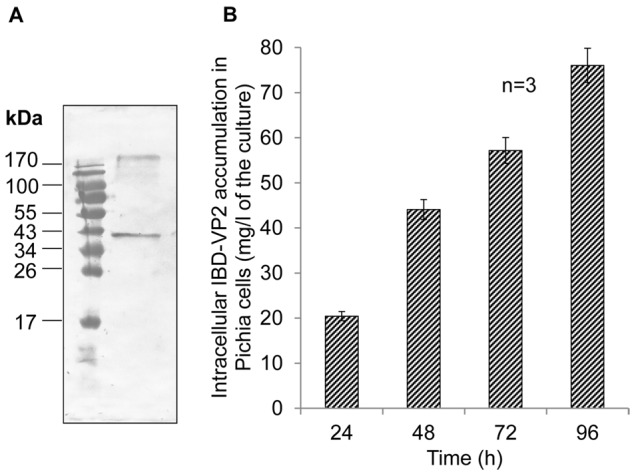
Characterization of recombinant IBD-VP2 produced in Pichia pastoris.(A) A 12-µl aliquot of the P. pastoris cell lysate was separated by SDS-PAGE (12% (w/v) polyacrylamide) and blotted onto a nitrocellulose membrane. The antigen was detected using a rabbit anti-IBD-VP2 (1∶10,000) primary antibody and an alkaline phosphatase-conjugated goat anti-rabbit secondary antibody (0.12 µg/ml). The signal was detected with NBT/BCIP for 5 min at room temperature. (B) Intracellular accumulation level of IBD-VP2 in P. pastoris cultures following expression induction. Biological triplicates were used for each experiment.